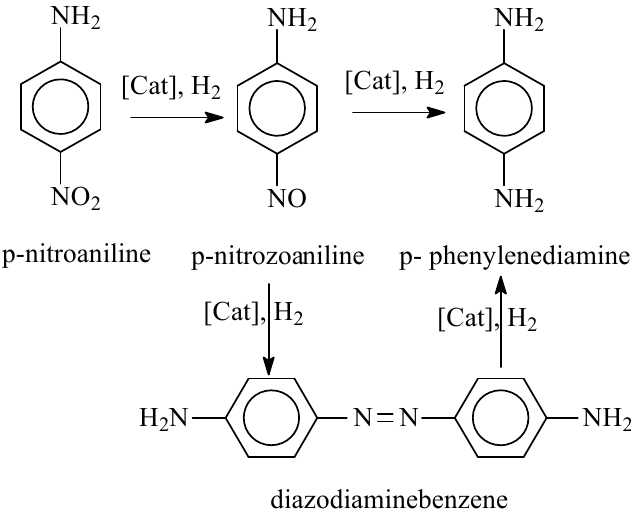
Figure 1. The scheme of 4-nitroaniline hydrogenation to 1,4 phenylenediamine.